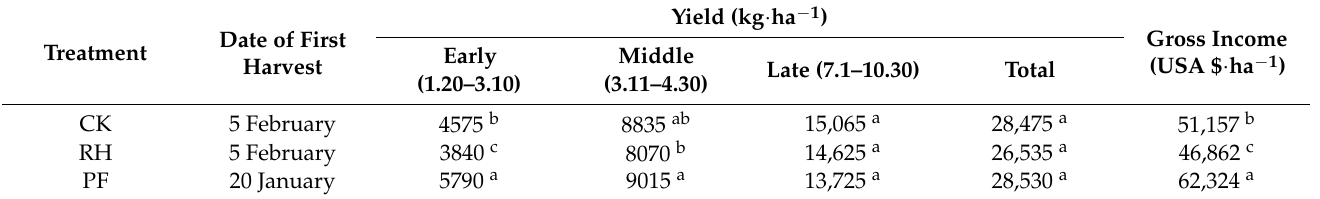
Table 1. The effects of mulching on asparagus mean yield and gross income in the plastic tunnel. Different lowercase superscript letters within the same column indicate significant differences at p <